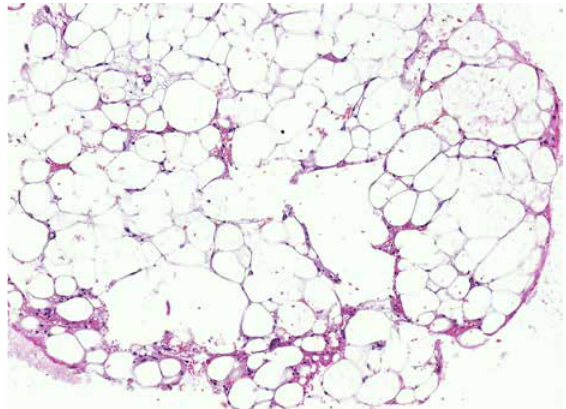
Figure 5: Structure of lipoma, consisting of mature yellow adipose; tissue with calcification. Hematoxylin-eosin staining. Magnification 300x